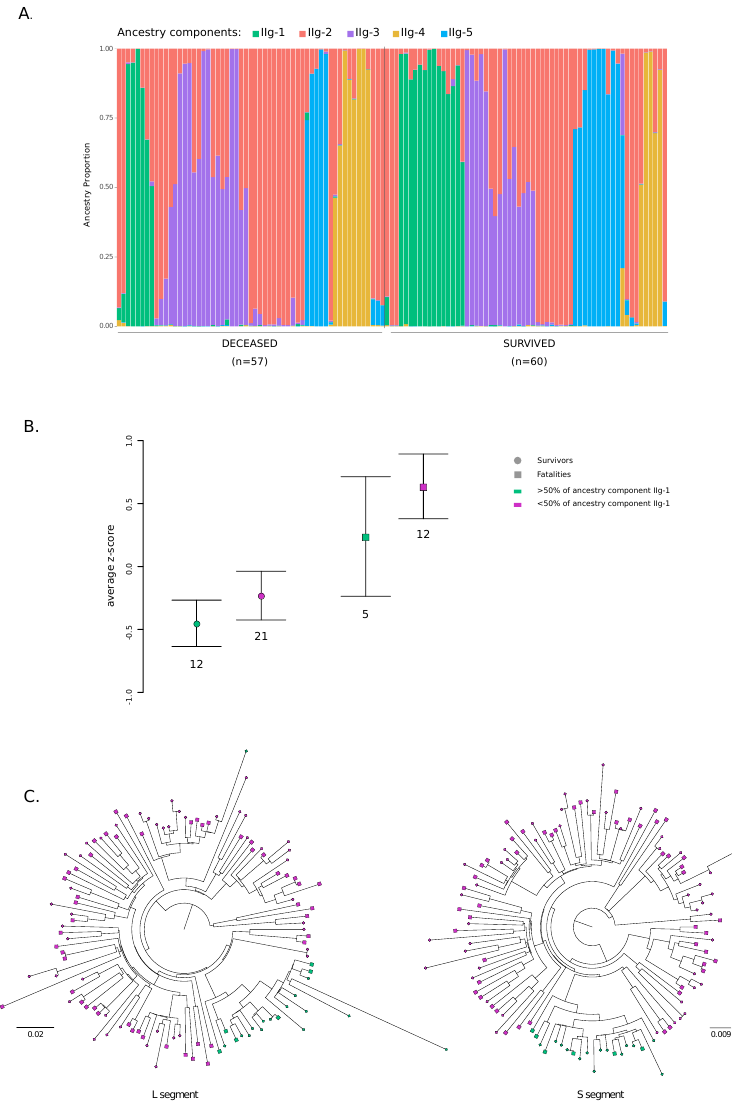
Figure 4. Population structure for lineage IIg and association with clinical outcome. ( A ). Bar plot representing the proportion of ancestral population components from the STRUCTURE linkage model for K = 5. Each vertical line represents a LASV genome. Genomes are ordered by clinical outcome. ( B ) Comparisons of plasma viral loads (average z-scores) for patients infected with viruses having more or less that 50% of ancestry from component IIg-1. Values are reported as mean and standard error. ( C ) Phylogenies of the L and S segment for lineage IIg viruses were constructed using RAxML. Tips are coded to indicate disease outcome. Genomes with more that 50% of ancestry from component IIg-1 are in